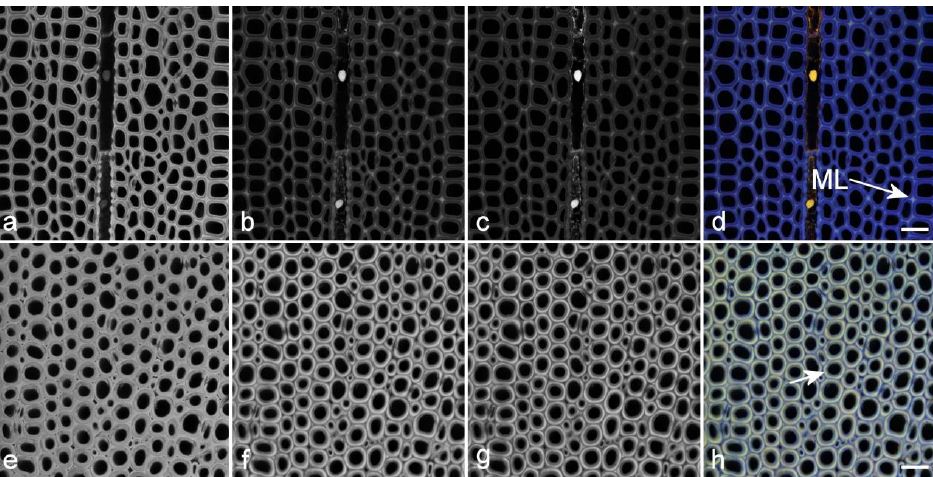
Figure 10. Spectral imaging of lignin autofluorescence using sequential excitation with emission ranges centered around the λ max for each excitation wavelength at a constant gain. Excitation at 355 nm (UV) ( a , e ), 488 nm (blue) ( b , f ) and 561 nm (green) ( c , g ). Color overlays are shown in ( d , h ). ( a – d ) Normal pine wood showing monochromatic lignin fluorescence at UV, blue and green excitations. Scale bar = 30 µm. ( e , h ) Pine compression wood showing the same range of excitation and emission highlighting the change in lignin distribution in this wood type compared to normal wood. UV excitation shows the same intensity, whereas blue and green excitations are significantly brighter compared to normal wood (images of normal and compression wood were acquired at the same gain). Blue and green excitation clearly show the more lignified middle lamella (ML) and outer secondary cell wall (short arrow) in the two specimens respectively. Scale bar = 30 µm.